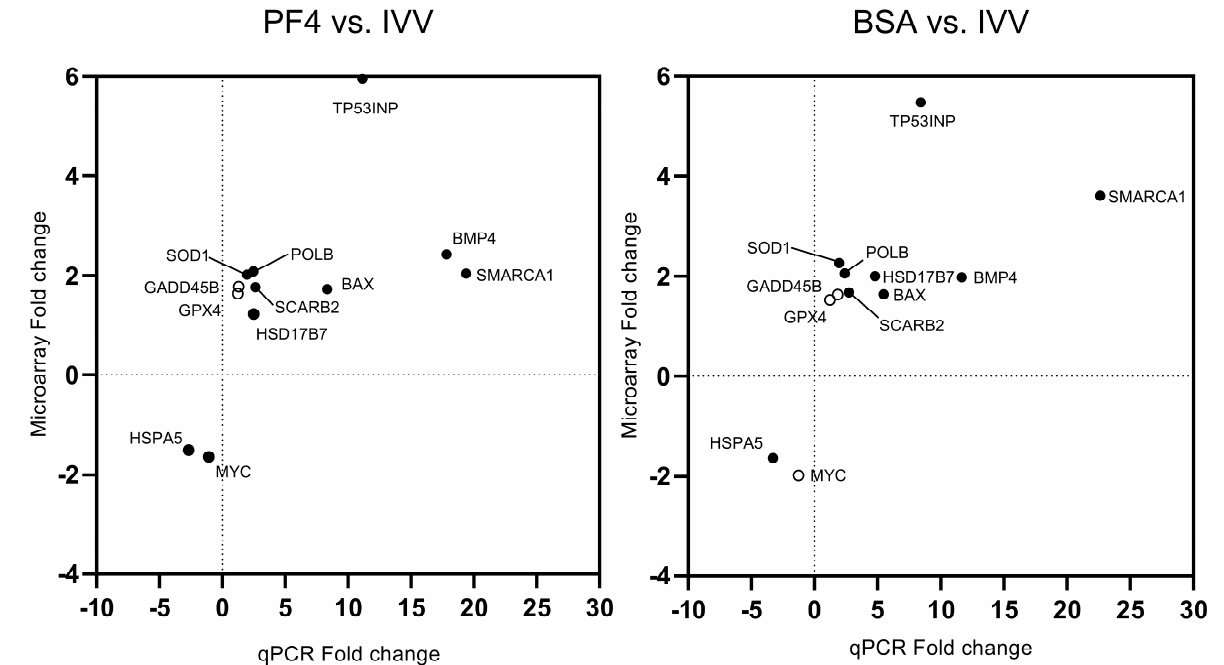
Figure 8. Comparison of the fold changes obtained by microarray and q-PCR analyses for the different validated genes in the experiment. The black circles represent genes where the significance obtained with the q-PCR was accordingly to those obtained by the microarray. White circles represent genes where the significance obtained with q-PCR differs from those obtained by the microarray.